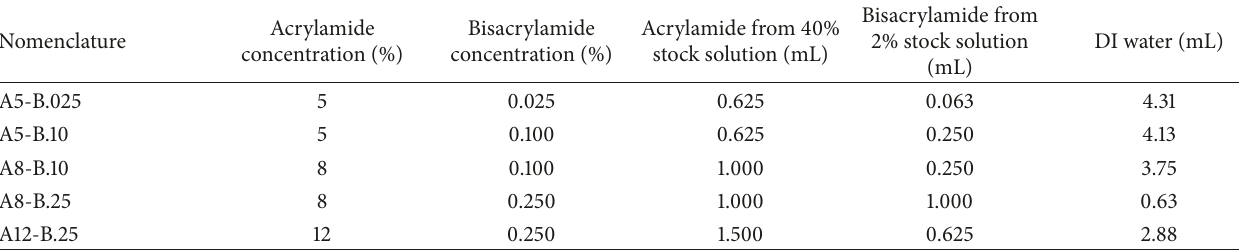
Table 1: Concentrations and volumes of acrylamide and bisacrylamide required to prepare polyacrylamide hydrogels of various